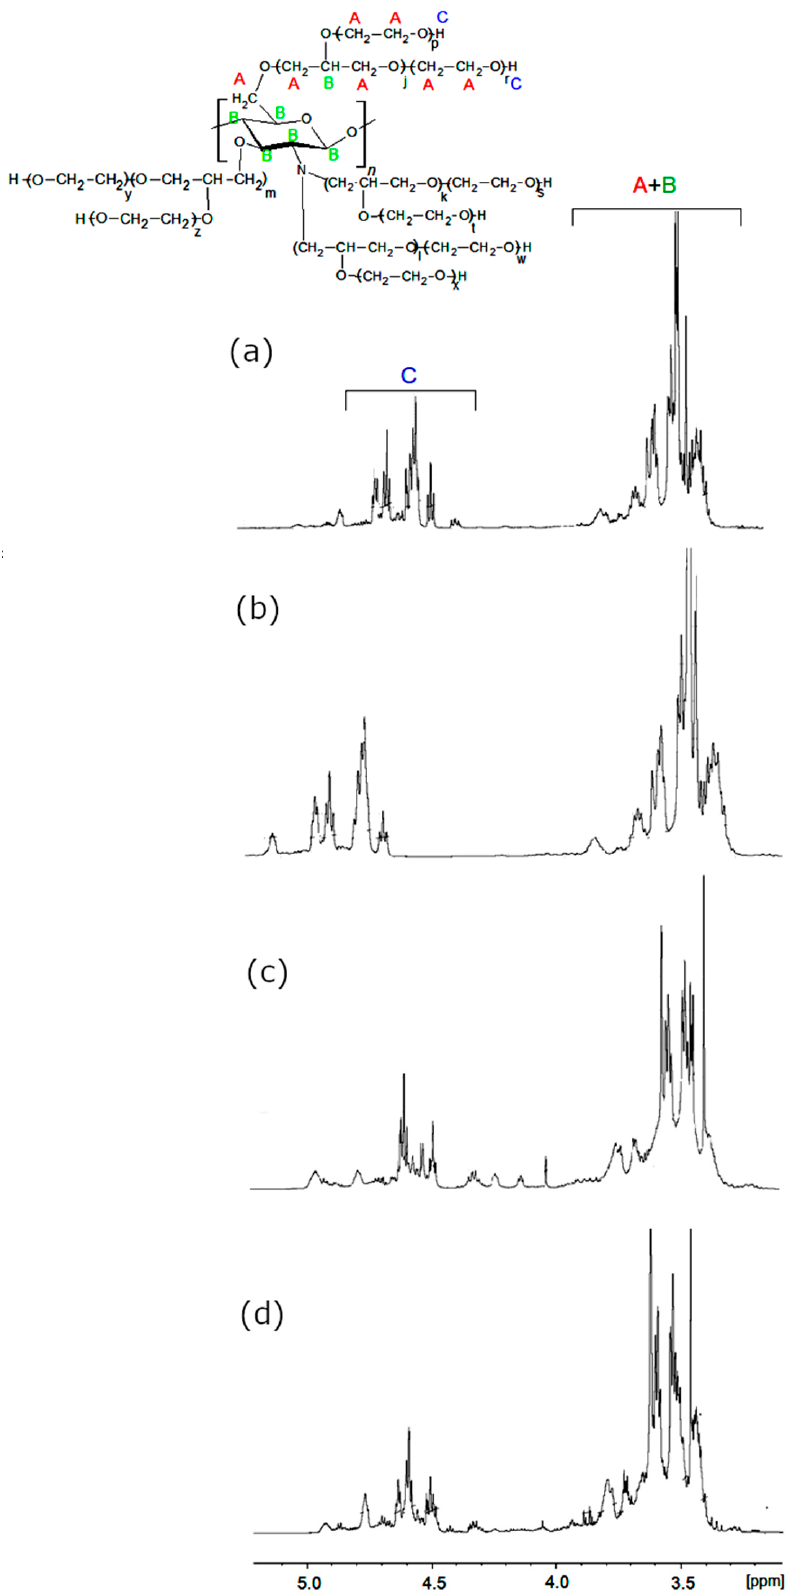
Figure 4. 1 H-NMR spectra of polyols (CS + H 2 O + GL) + EC ( a ), (CS + GLYC + GL) + EC ( b ), (CS + GL) + EC ( c ), and (CS + GL + EC) ( d ).